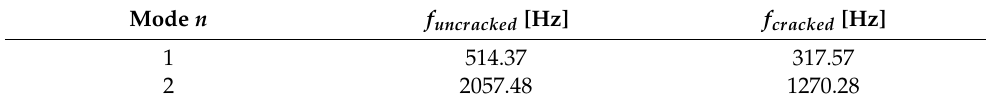
Table 5. Calculations of the first two natural frequencies for cracked and uncracked concrete